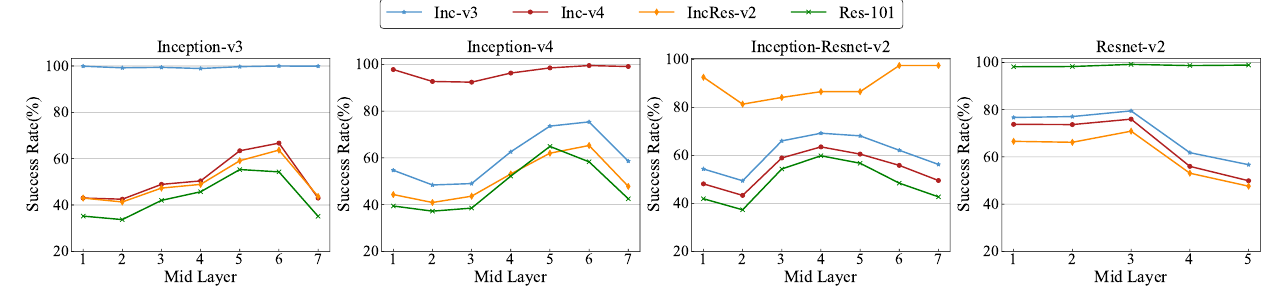
Figure 5. Evaluation of the robustness of the latent layers in four models.